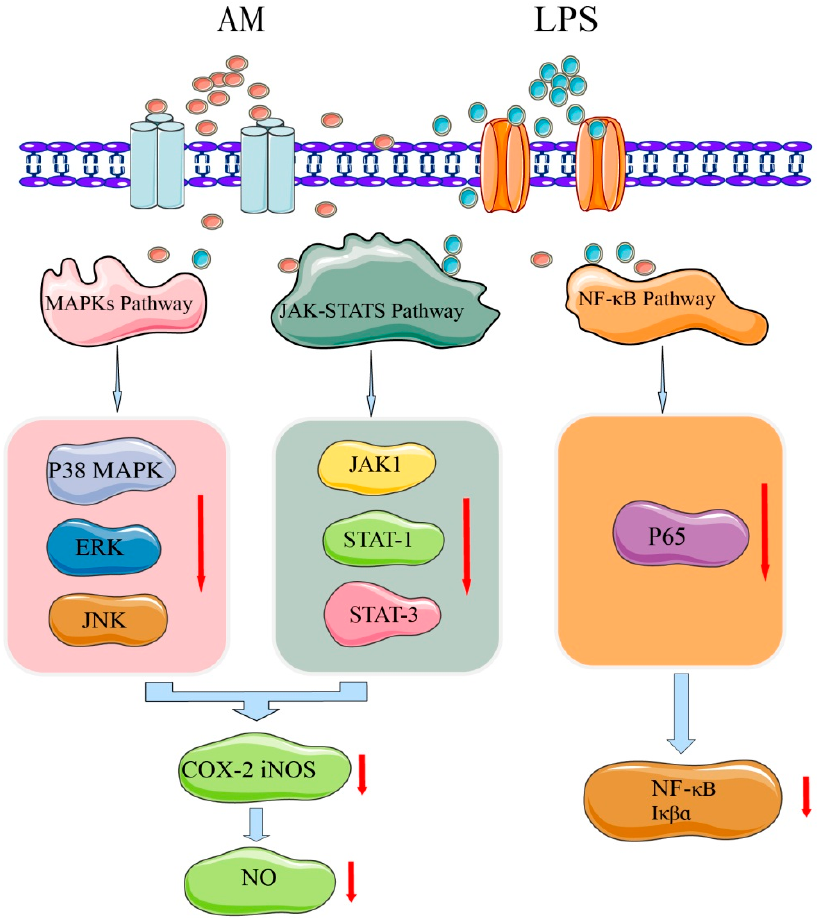
Figure 6. Mechanism of AM for its anti-inflammatory effects.